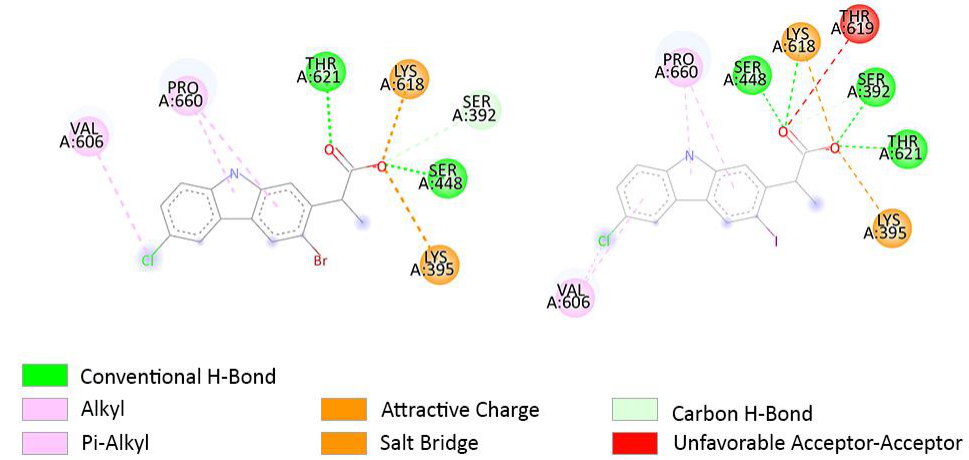
Figure 10. Predicted interactions between compounds 4 ( A ), 7 ( B ), and 10 ( C ) and the PBP3 receptor, and cefotaxime ( D ) in its experimentally determined site. Images were obtained using Discovery Studio Visualizer [33].